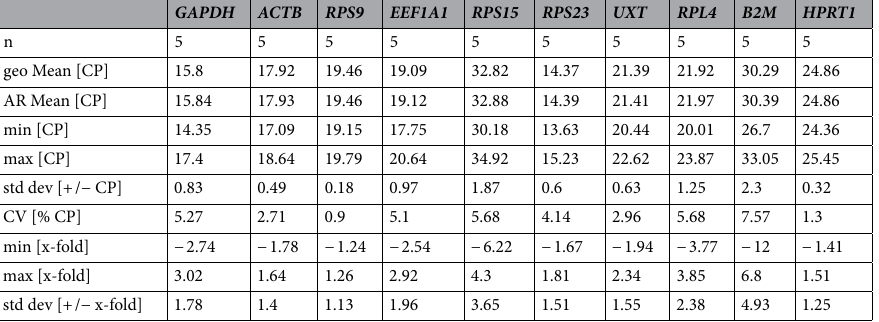
Table 10. Analysis of parameters based quantitative cycling points (CP) for 10 candidate RGs in